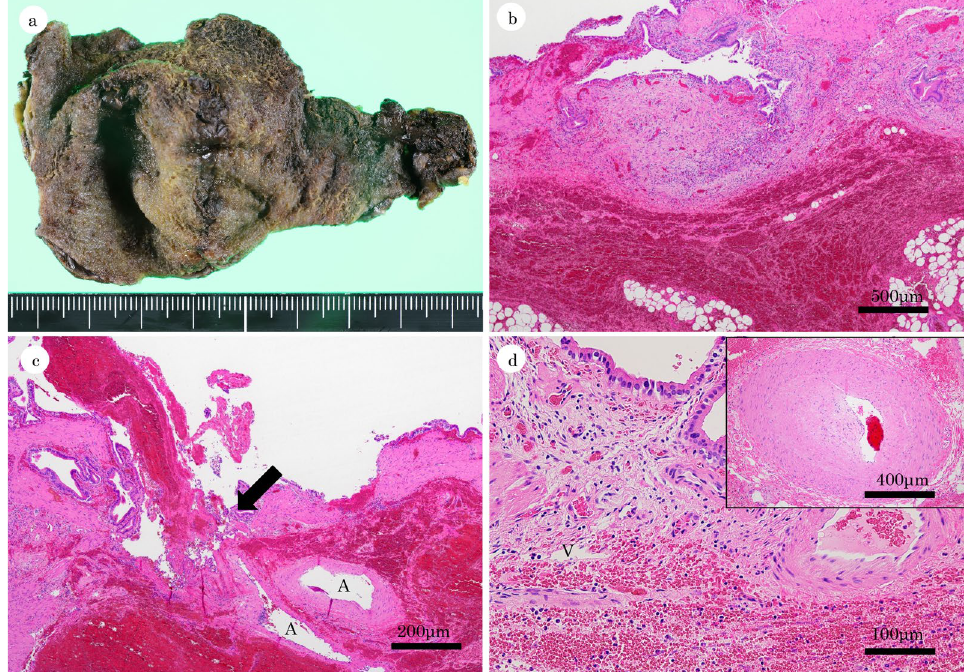
Fig. 3 Macroscopic and microscopic findings. Macroscopic view of the luminal surface of the removed gallbladder showing extensive hemorrhage attached on the eroded mucosal tissue ( a ). Histology (low power view) shows widespread hemorrhage in the subserosa ( b ). Histology (medium power view) shows hemorrhagic ulceration with an exposed blood vessel (arrow). Abnormal distribution of arteries (A) was noted in the submucosa ( c ). Histology (high power view) showing hemorrhagic extravasation from a small vein (V). Arteriosclerosis with eccentric intimal hyperplasia of a small‑sized artery was also seen in the subserosa (inset) ( d